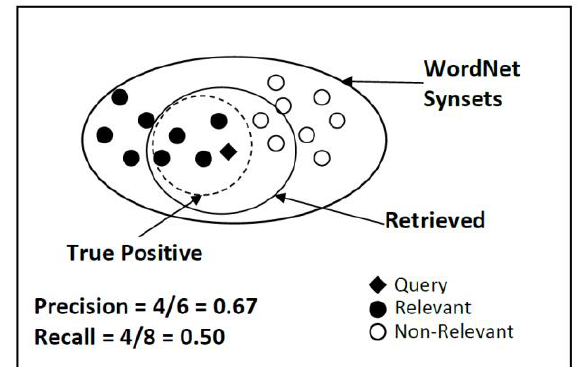
Figure 1. Precision and recall definition.